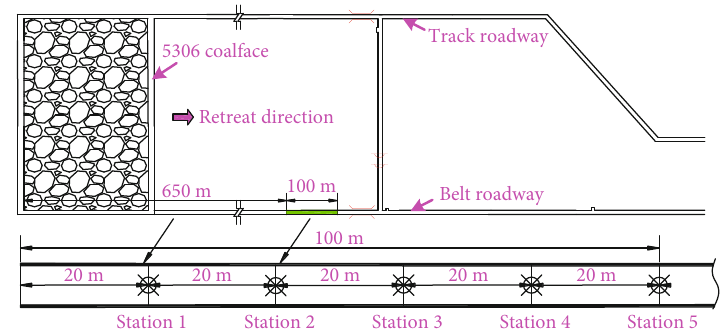
Figure 12: Layout of the roadway deformation monitoring stations.